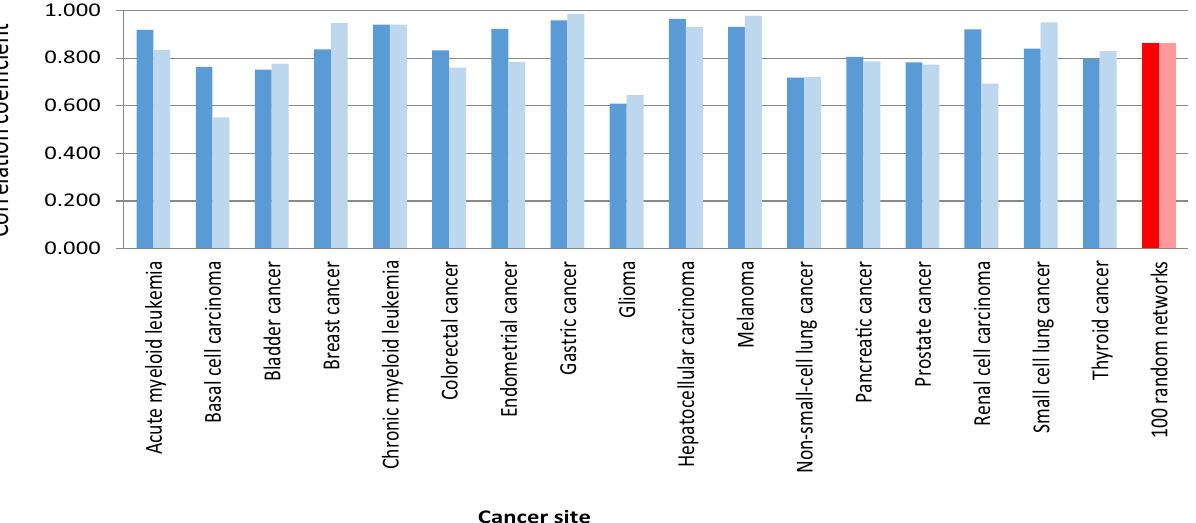
Figure 3. Correlation coefficient between total support and closeness, hierarchical closeness. Blue columns indicate the results on 17 cancer signaling networks and the red represents those on 100 random directed networks generated with | V | = 50 and 49 ≤ | E |≤ 100. Dark red represents the value of hierarchical closeness (R = 0.866; P = 0.0001) whereas light red is the value of closeness (R = 0.866; P = 0.0001) (see Table S1 for